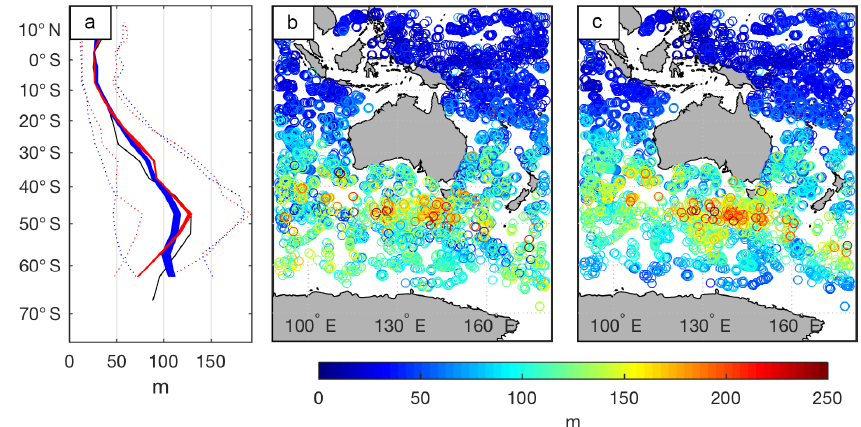
Figure 3. (a) The zonal mean of the OceanMAPS versions 2.2.1 (blue) and 3.0 (red) MLD corresponding to Class 4 profiles over the study period. The range of values between forecast time steps ( + 0h, + 24h, + 48h etc.) is indicated by the line thickness. The 5th and 95th percentiles for each model are shown by the dotted lines. The observed mean (from Fig. 2) is shown in black. The forecasts at model time + 24h are shown in (b) for version 2.2.1 and (c) for version 3.0.